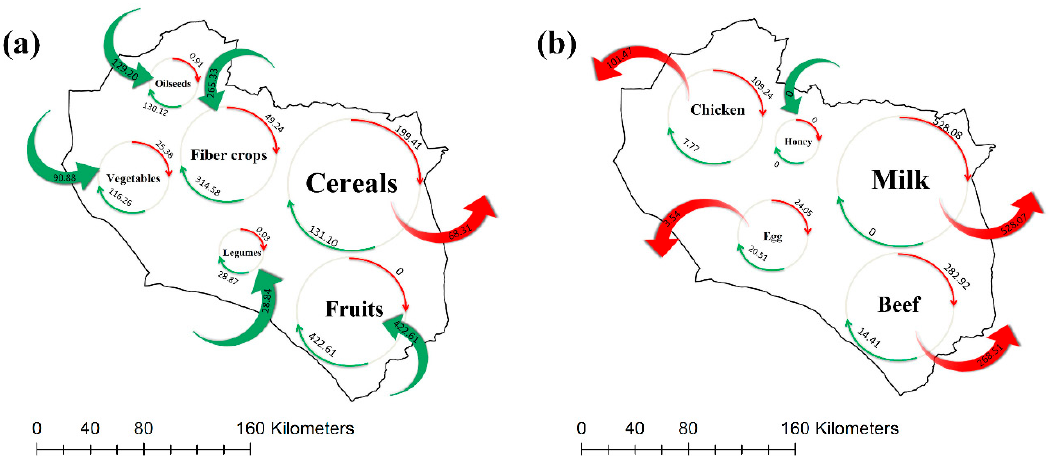
Figure 6. The inter and intraregional amount of virtual water transferred in crop ( a ) and livestock trade ( b ). Figures on the rotating arrows represent the internal virtual water flows, while the boundary arrows show the virtual water trade at the province level. Green and red colors refer to import and export, respectively. The size of circles represents the amount of water withdrawal in domestic production.